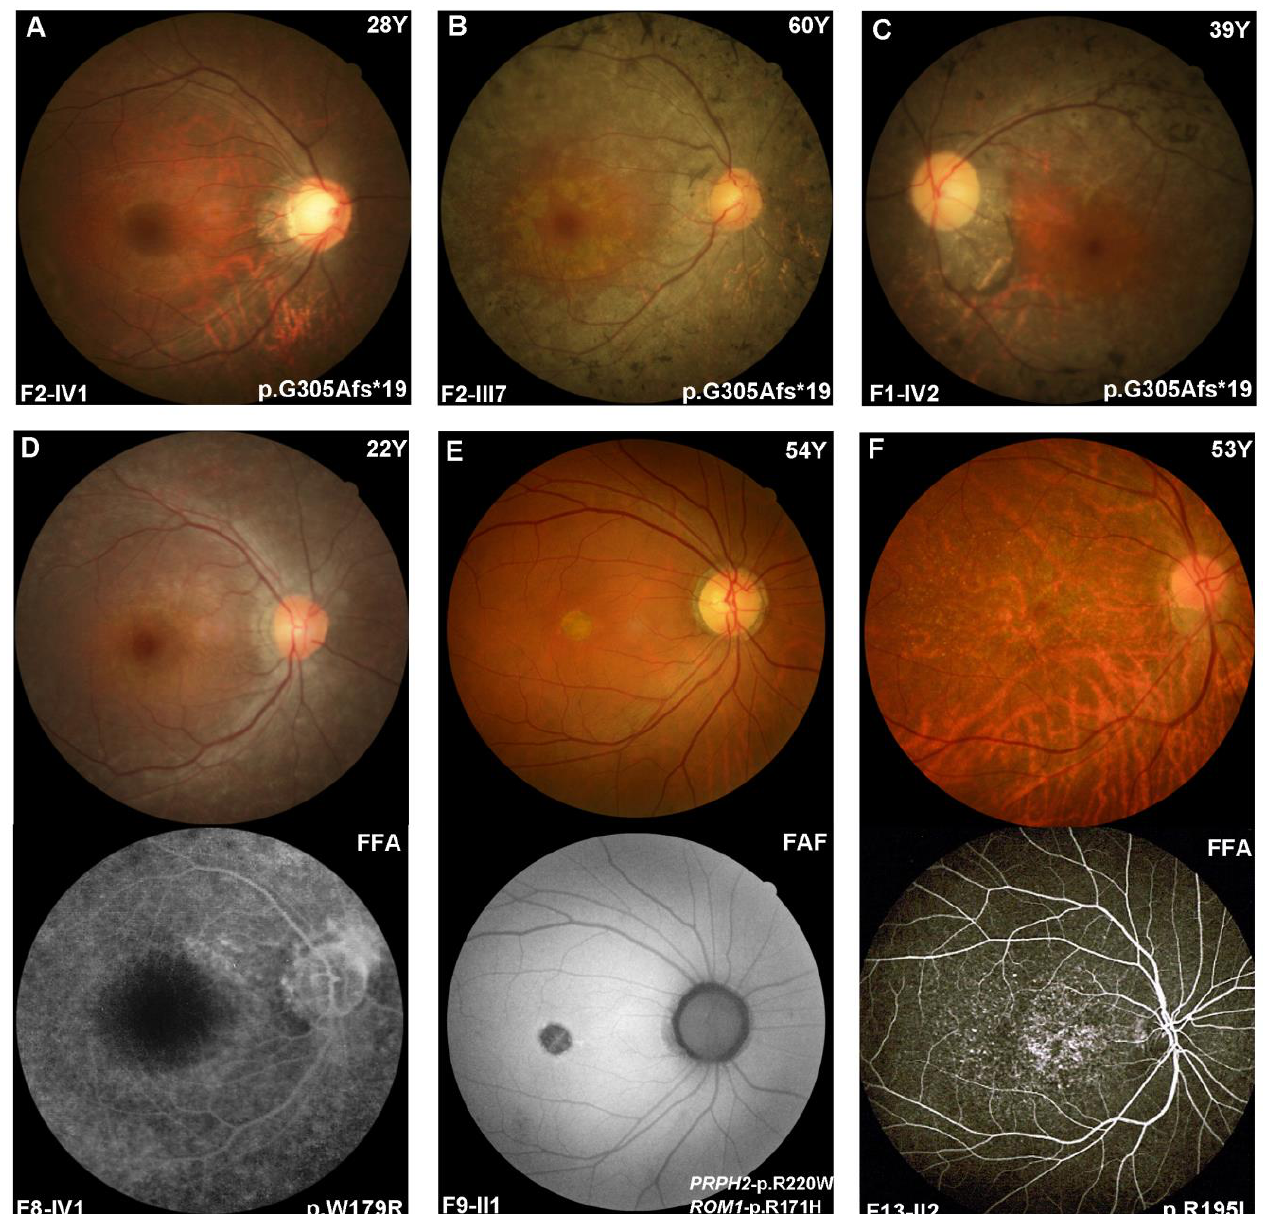
Figure 2. Fundus performance of in-house patients with PRPH2 -associated retinopathy. ( A – D ) Pale optic discs, narrowing of retinal vessels, widespread tapetoretinal degeneration, macular atrophy in different degrees, and bone-spicule pigment deposits in the mid-peripheral area were observed among patients diagnosed with RP. Mottled hyper-fluorescein spots were observed in the whole posterior pole except for the macula area. ( E ) A small round atrophic lesion in the macula that presented as a hypoautofluorescent lesion in the autofluorescence image was observed in a patient with adult vitelliform macular dystrophy. ( F ) A patient presented with granular pattern retinal pigment epithelium mottling diffusely throughout the macular area that showed widespread mottled hyper-fluorescein in the late stage of fluorescein fundus